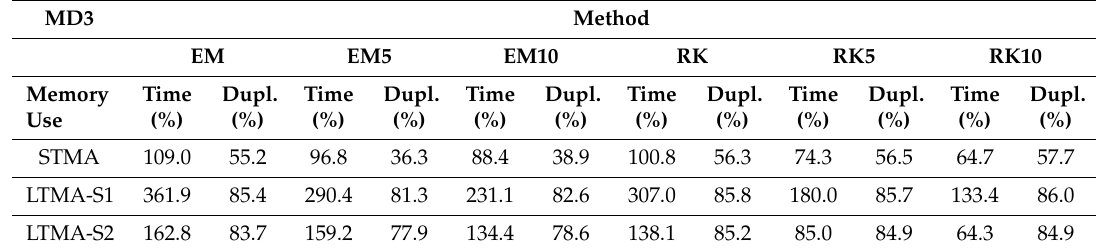
Table 32. Mean value of the calculation Times (Time) and Duplications (Dupl.) in respect to no additional memory use for 50 independent runs using EM, EM5, EM10, RK, RK5, and RK10 for MD3.